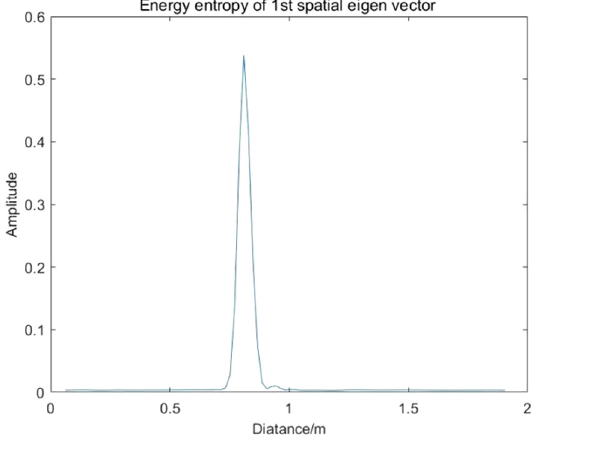
wavelet denoising.